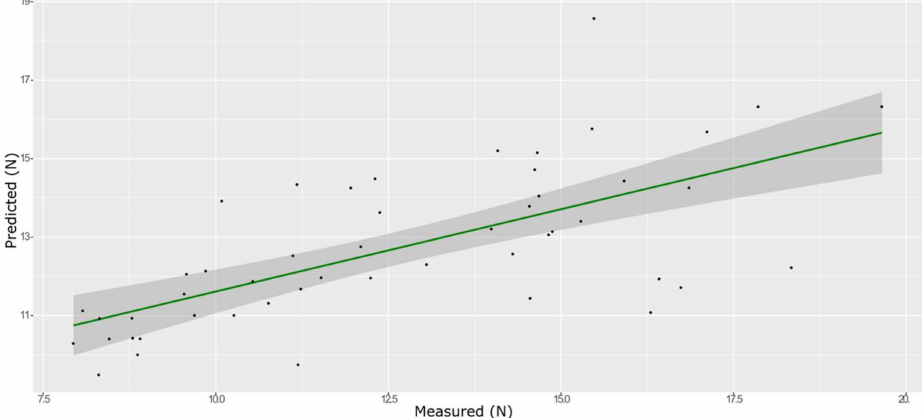
Figure 10. PLS model for BH on the test set, using the full spectral range.